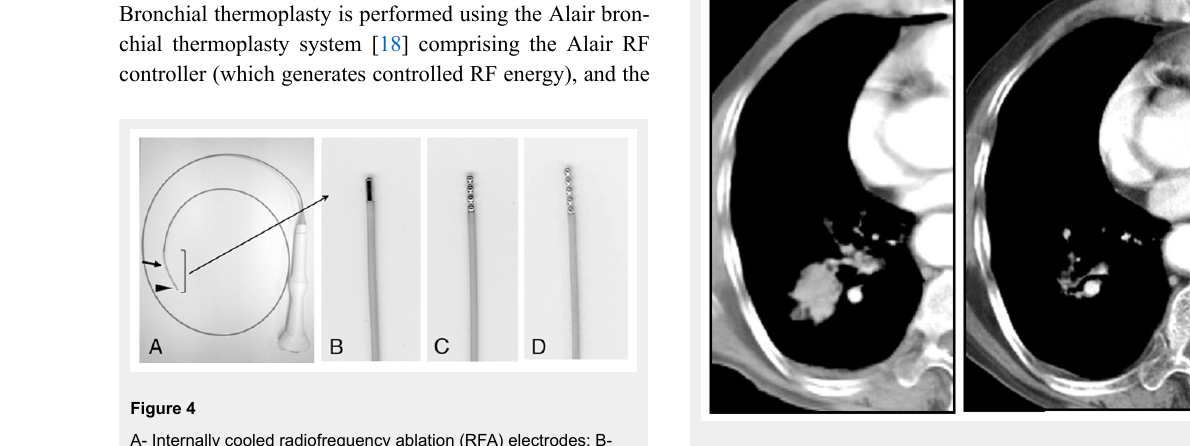
A- Internally cooled radiofrequency ablation (RFA) electrodes; B- 5-mm cylindrical active tip; C- 8-mm active tip with four beads; and D-10-mm active tip with five beads. Chest CT of a patient treated with RFA- before and after